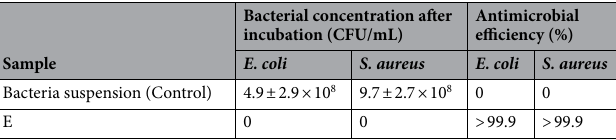
Table 3. Antimicrobial efficiency of hand gels.